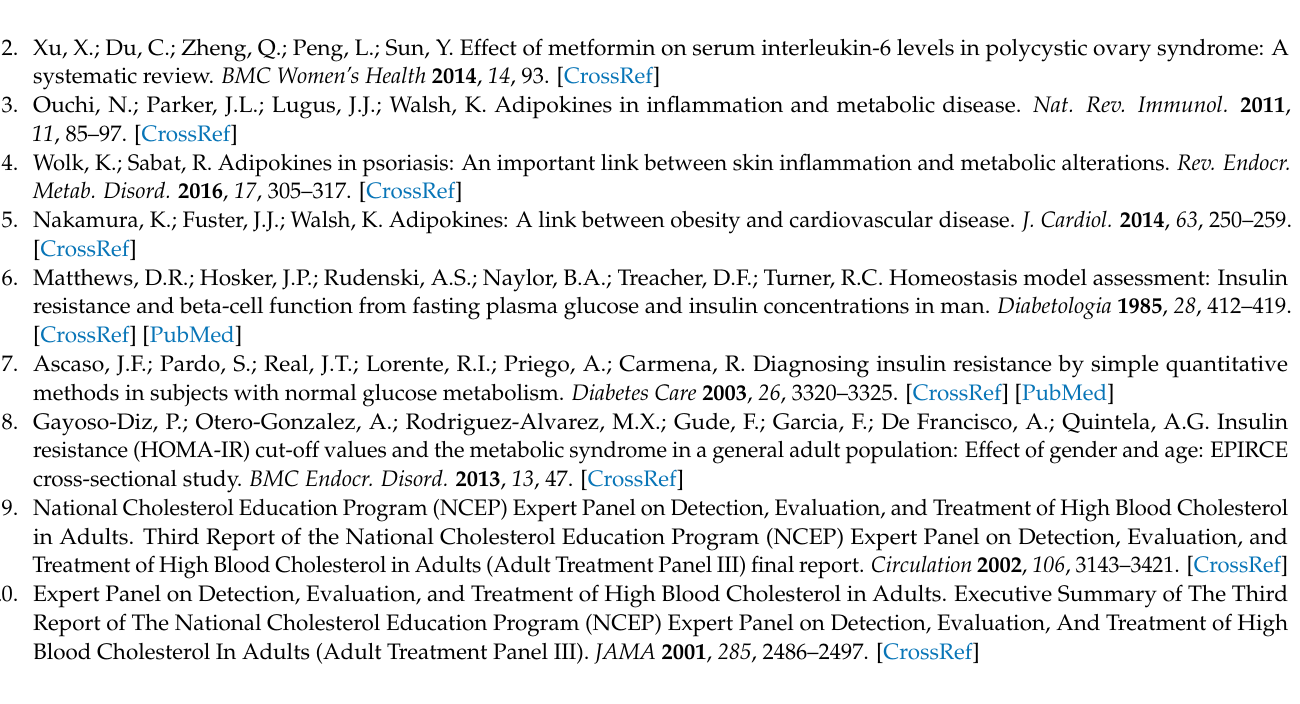
Disclaimer/Publisher’s Note: The statements, opinions and data contained in all publications are solely those of the individual author(s) and contributor(s) and not of MDPI and/or the editor(s). MDPI and/or the editor(s) disclaim responsibility for any injury to people or property resulting from any ideas, methods, instructions or products referred to in the